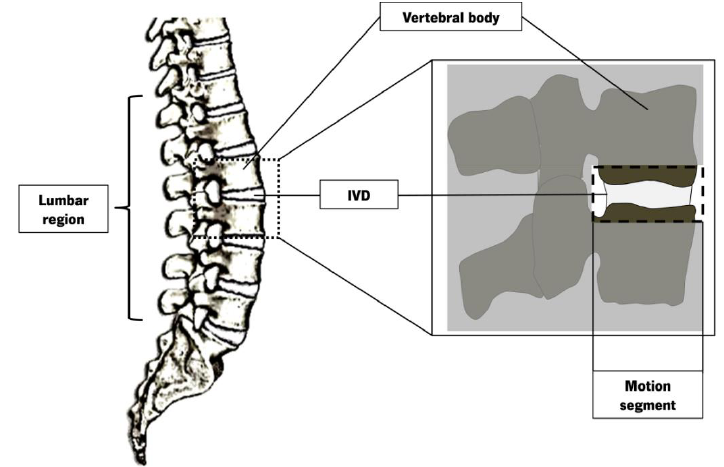
Figure 1. Schematic representation of the motion segment preparation. This structure is highlighted by the dashed rectangle. To obtain a motion segment, two vertebrae are cut parallel and transversely, obtaining an assemble composed by two half vertebra with a disc in between.